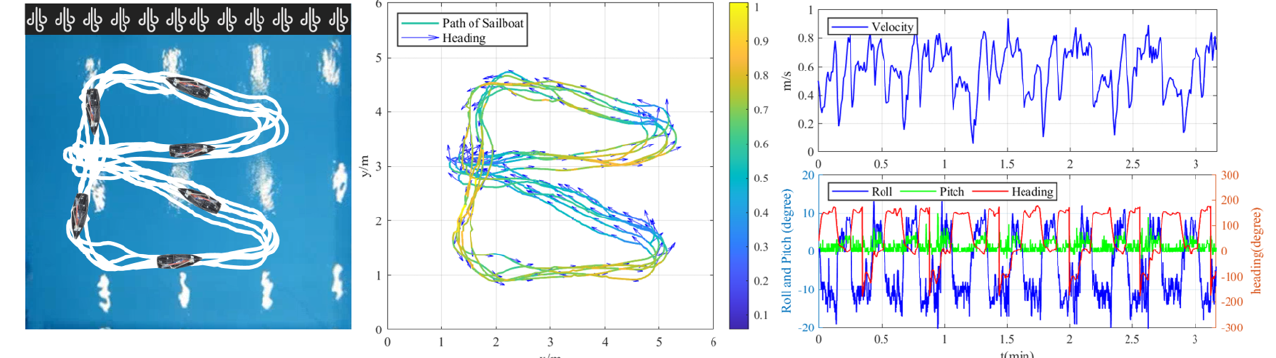
Figure 8. A remote sailing test in STAr by a practised researcher. The left picture shows the wind direction and sailing path in real test environment. In the middle figure, the path is added with arrows to represent the heading and color-bar distribution to distinguish the speed magnitude. The right figures are velocity and attitude versus time.